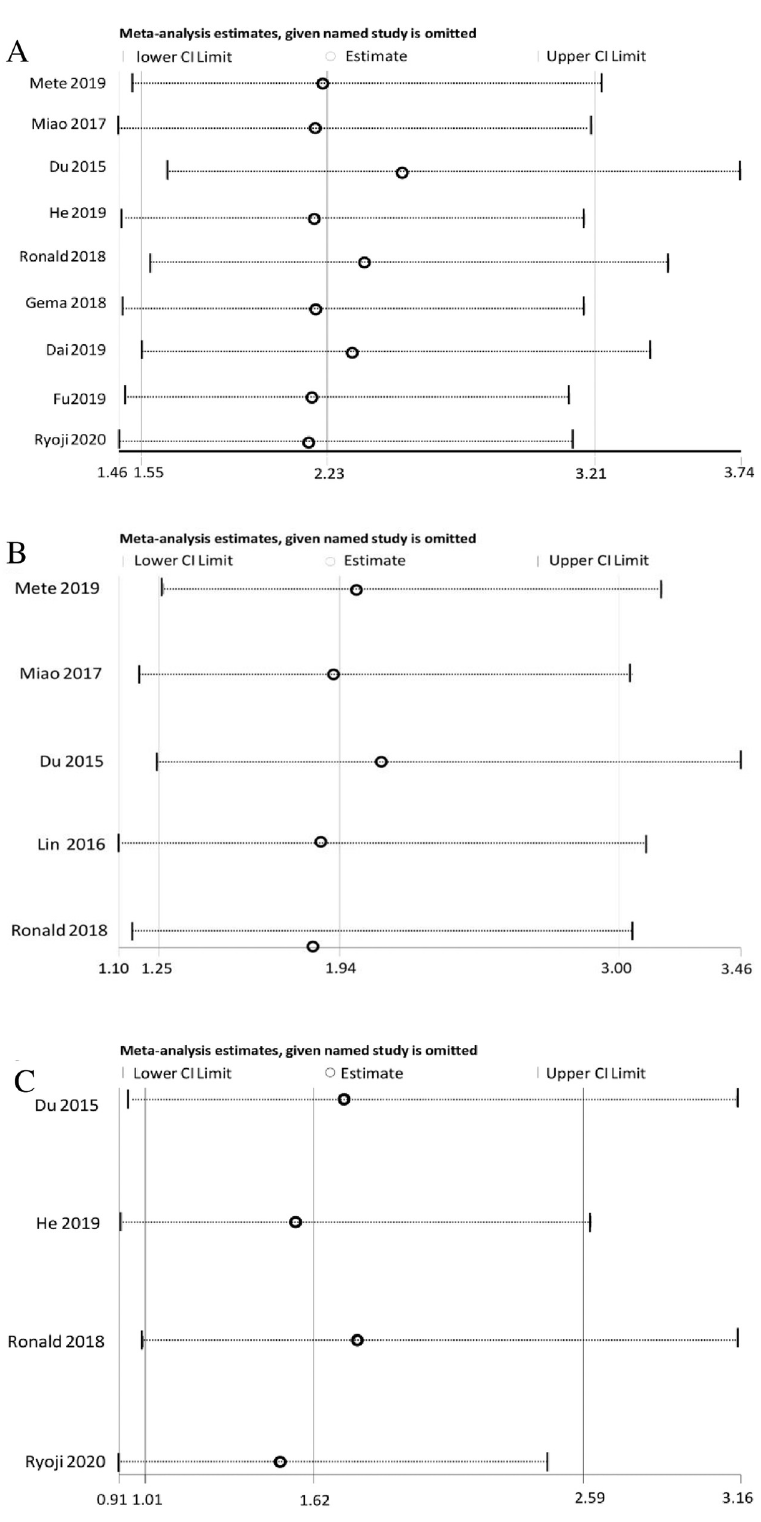
Fig 3. Sensitivity analyses of HRs: A. OS B. DMFS C.